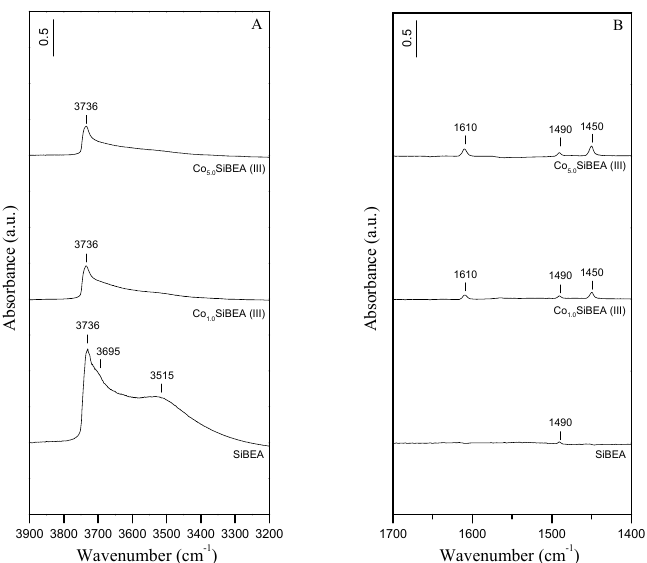
Figure 4. ( A ) FTIR spectra (vibration region of the OH groups) recorded at room temperature of SiBEA, Co 1.0 SiBEA(III), and Co 5.0 SiBEA(III) and ( B ) FTIR difference spectra recorded at room temperature of SiBEA, Co 1.0 SiBEA(III), and Co 5.0 SiBEA(III) after adsorption of pyridine (133 Pa) for 1 h